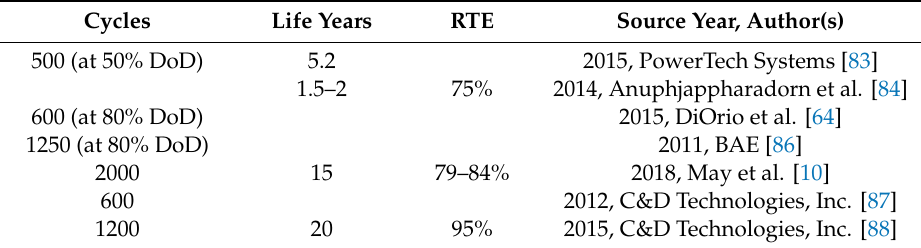
Table 16. Cycles, life years, and RTE—lead acid